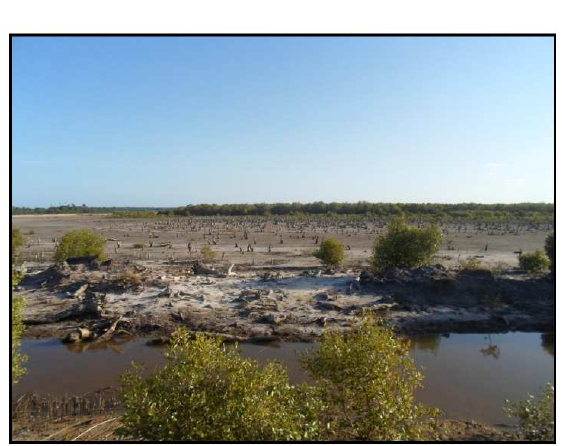
Figure 9. The photo depicts widespread mangrove clearance for shrimp farming in Mafia Island. The photo was taken in March,